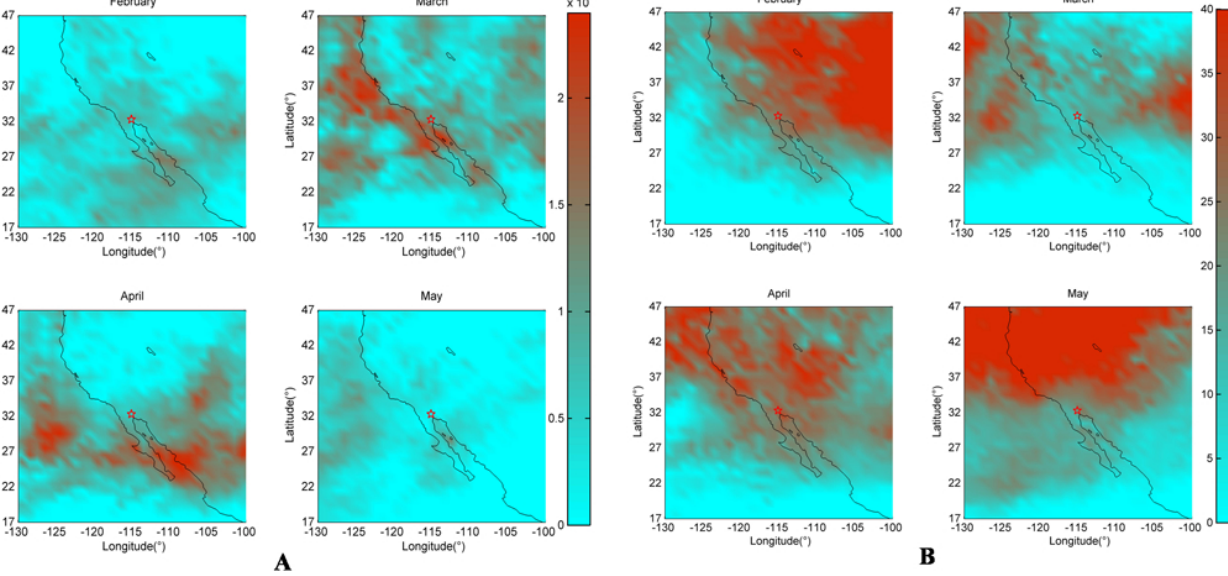
Fig. 2. Distributions of 1G CO (A) and 1G O (B) associated with 5 April 2010 Baja California earthquake from February to May 2010, red 3 star stands for the epicenter, CO unit: molecm − 2 , O 3 unit: